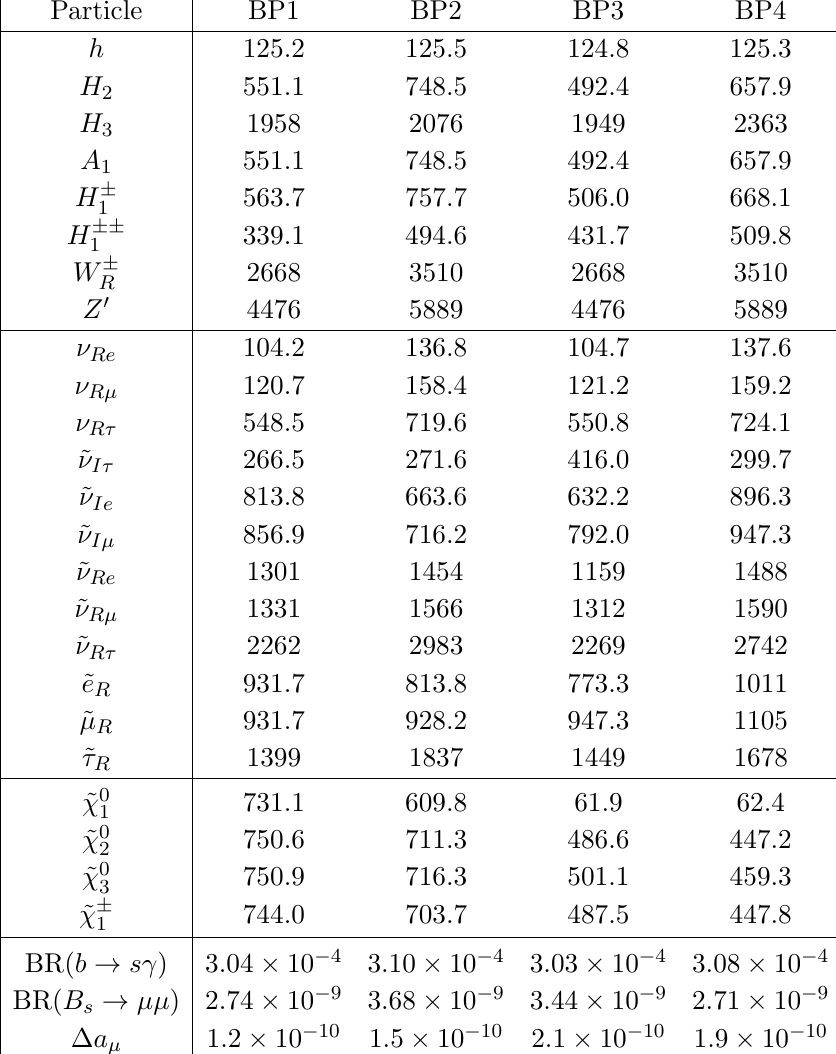
Table 2 . The relevant particle spectrum of the four adopted benchmark points, presented together with the values of several low-energy observables suitable for constraining the model. All of the sleptons given here are RH. The subscripts R and I in sneutrinos refer to real and imaginary parts, respectively. All masses are given in